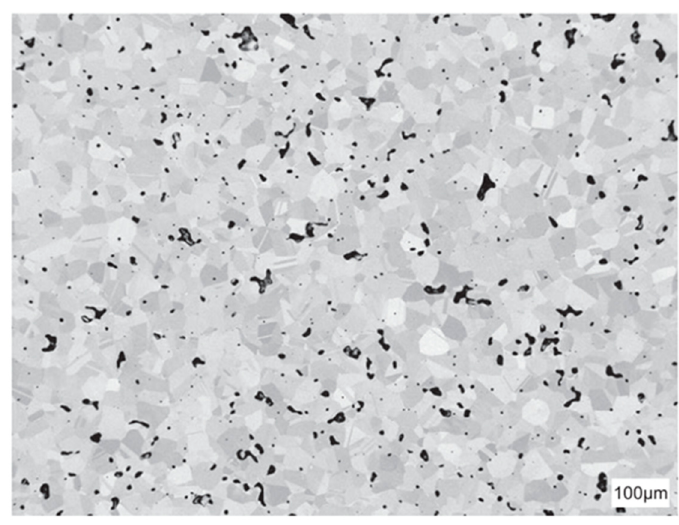
◦ C in vacuum atmosphere